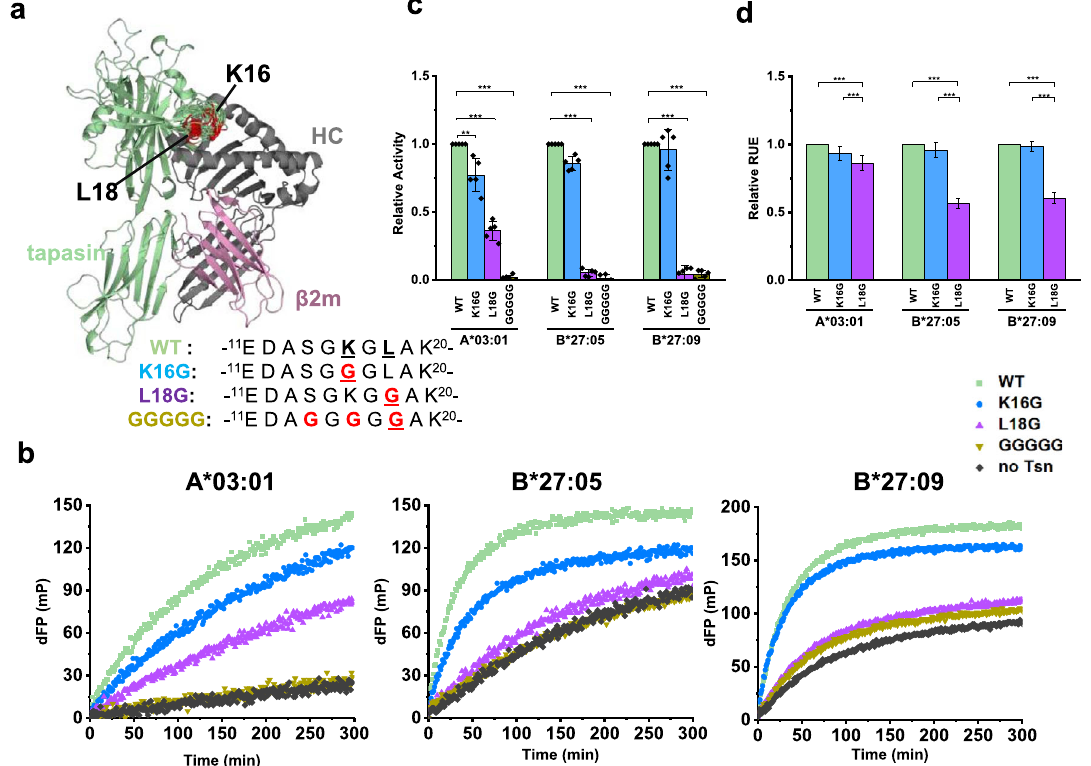
Fig. 3 The role of tapasin scoop loop 11 – 20 in mediating peptide exchange of MHC-I. a The loop 11 – 20 of tapasin in the modeled MHCI-ERp57-Tsn complex (ERp57 is not shown here). Residue 16 and 18 were colored red. The sequence of tapasin scoop loop 11 – 20 mutants are shown besides. b Representative peptide exchange pro fi les of 500nMA*03:01/photoKK9, B*27:05/photoRL9, B*27:09/photoRL9 in the absence (black) and presence of equimolar amounts of ERp57- Tsn WT (light green), ERp57- Tsn L18G (sky blue), ERp57-Tsn K16G (purple), and ERp57-Tsn GGGGG (golden). FITC-KK9 for A*03:01 and FITC-RL9 for B*27:05. FTIC-IF9 (IRAAK FITC PPLF) was used for better resolution of the kinetics for B*27:09. dFP means the baseline was subtracted. c Relative catalytic activity of ERp57-Tsn loop 11 – 20 mutants compared to ERp57-Tsn WT towards three allotypes. The observed association rates ( K on_Tsn_mutant ) were determined for each mutant on the corresponding MHC-I allotype and relative activity was calculated by the formula of ( K on_Tsn_mutant – K on_Tsn - )/ (K on_Tsn_WT – K on_ Tsn - ) . Error bar (SD) was calculated from fi ve independent experiments. d Normalized free energy values of the modeled tapasin mutants calculated in Rosetta Energy Unit (REU). Error bar (SD) was calculated from 100 data points. In c comparison of loop mutants to WT, the two-sample unequal variance Student ’ s t test was performed, in d mean comparison method is Tukey, * p <0.05, ** p <0.01, *** p